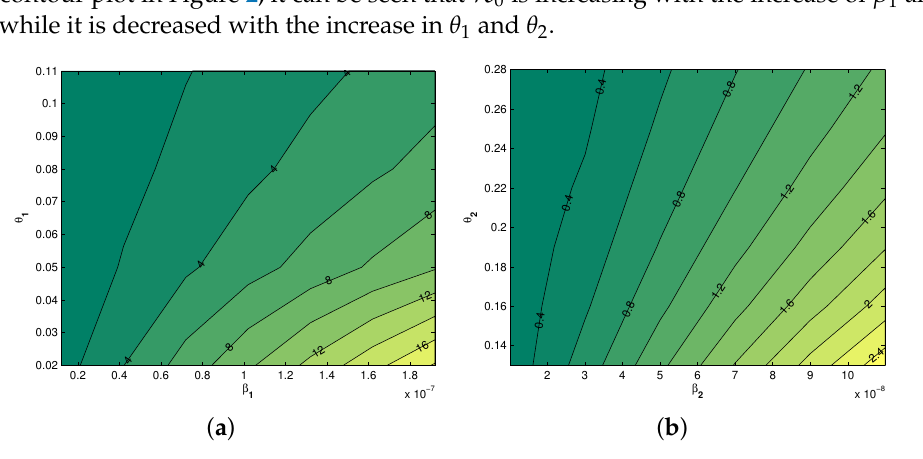
Figure 2. Contour plot of ( a ) θ 1 versus β 1 and ( b ) θ 2 versus β 2 as a function of R 0